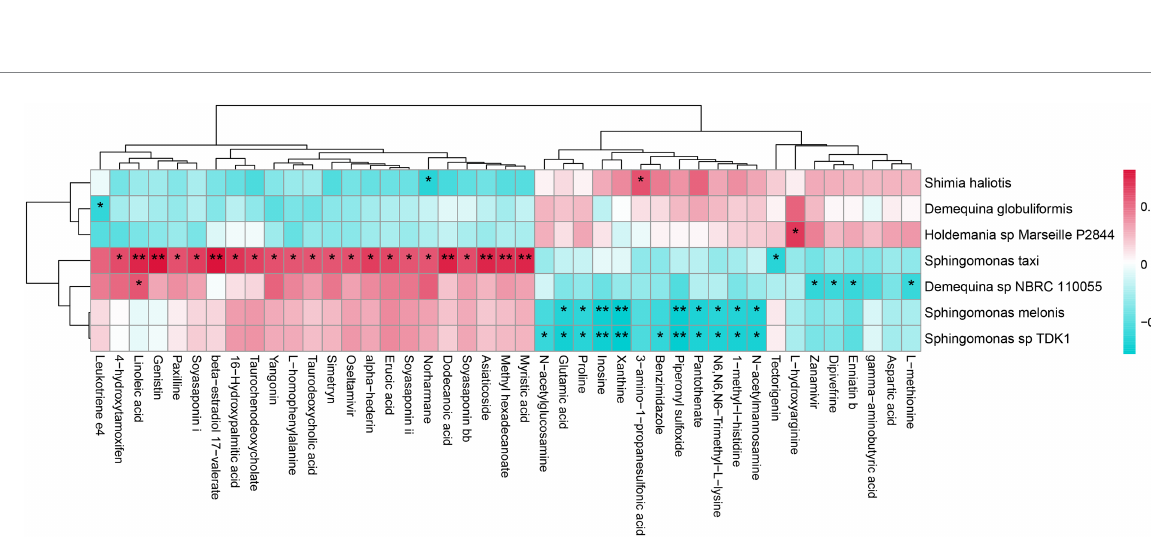
FIGURE 7 The correlation analysis between intestinal bacterial species and metabolites of L. vannamei . * represents a significant difference (* p < 0.05; ** p <